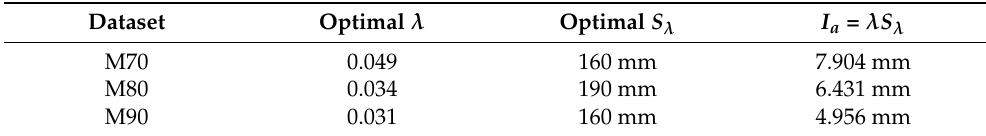
Table 7. Optimal λ , S λ and I a for M70, M80 and M90 decadal